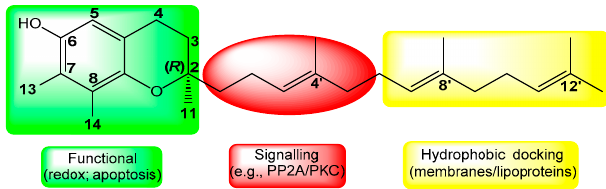
Figure 2. Tocotrienol (T-3) chemical structure and molecular biology of its major structural domains (adapted from [2]).